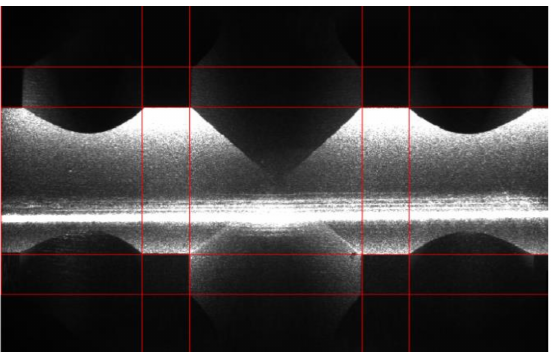
Figure 5. An example of a good alignment between the overlaid mesh (red lines) and the reference plate, illuminated by a laser line. The central channels are in the center of the image. The white horizontal line is an overexposed laser line since a camera’s exposure time is increased from 400 µ s to 30 ms.